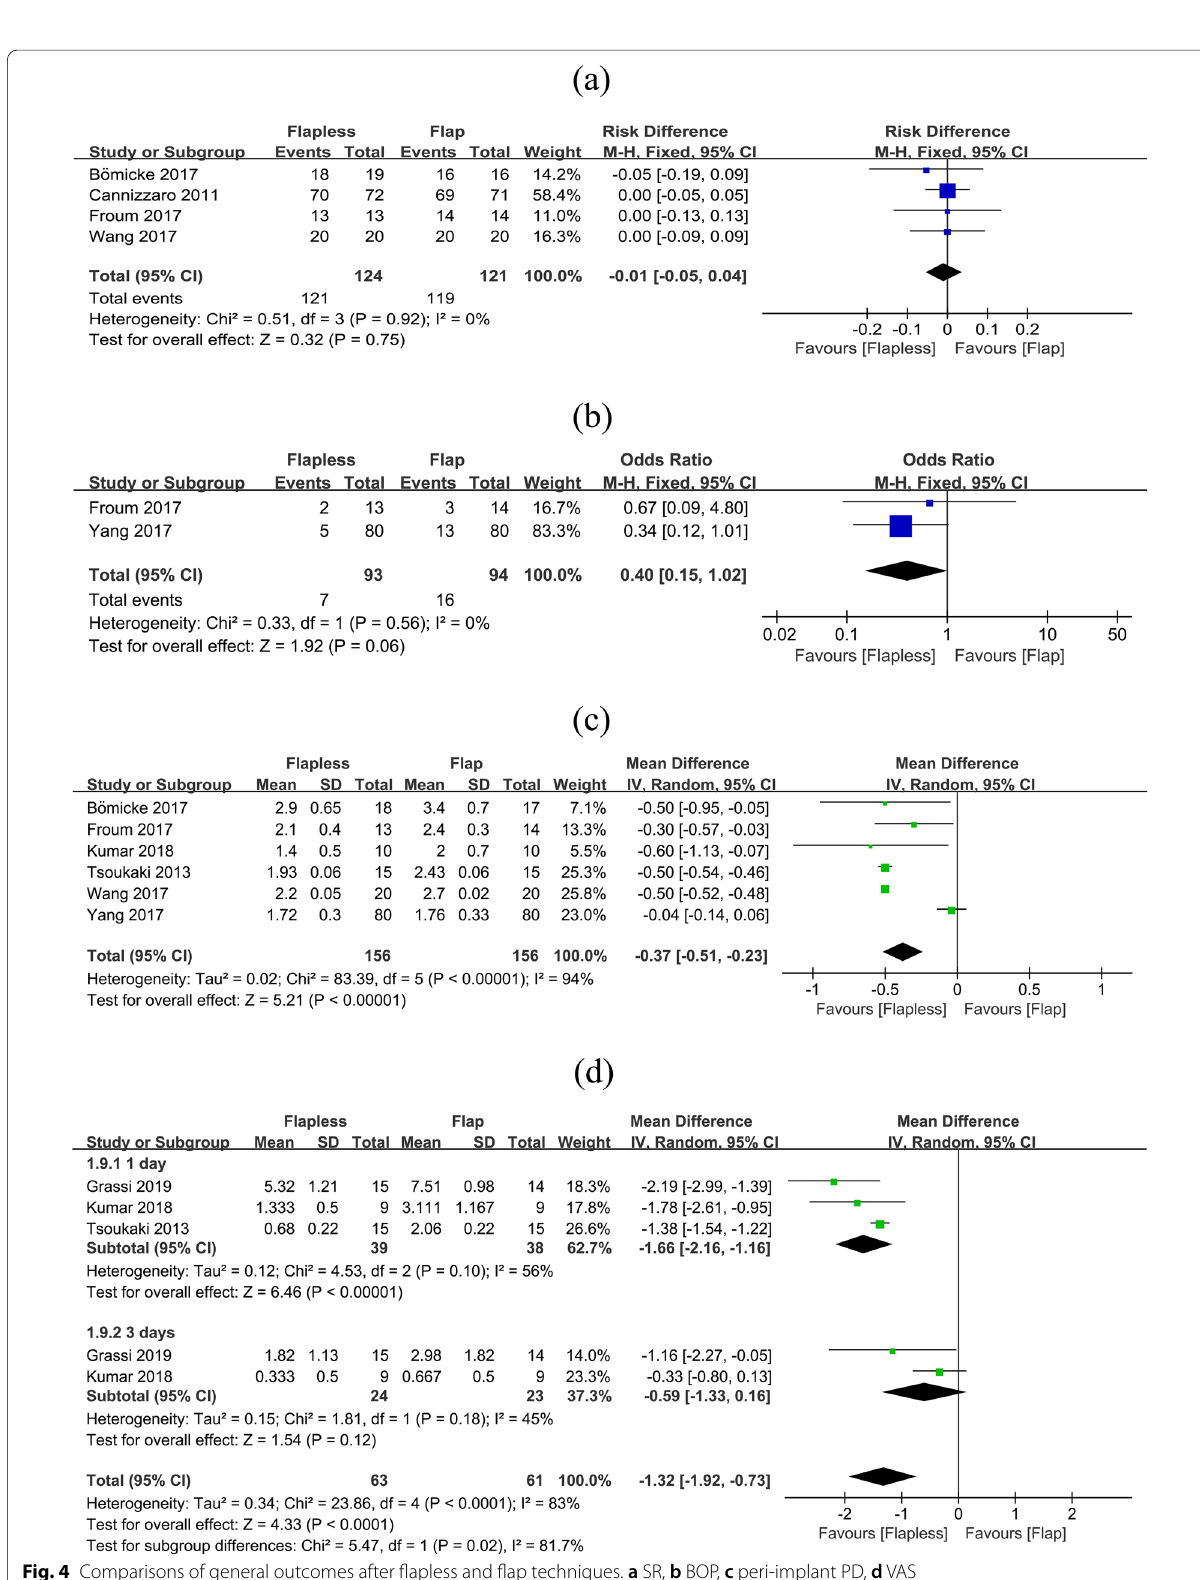
Fig. 4 Comparisons of general outcomes after flapless and flap techniques. a SR, b BOP, c peri-implant PD, d